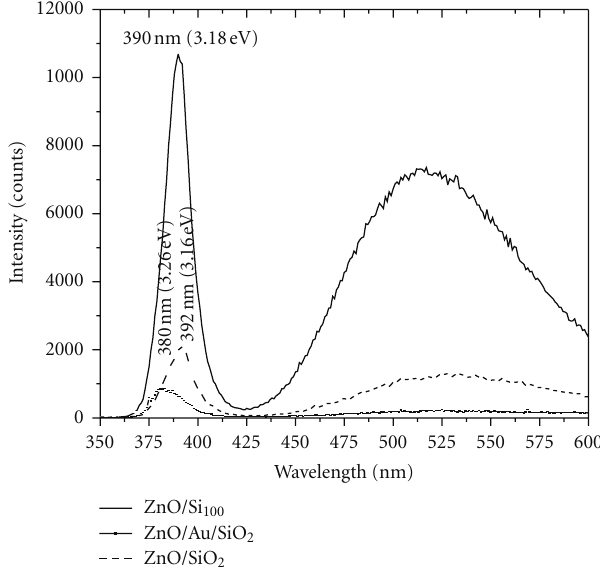
Figure 5: Room temperature CL spectra of ZnO samples grown on three di ff erent substrates by